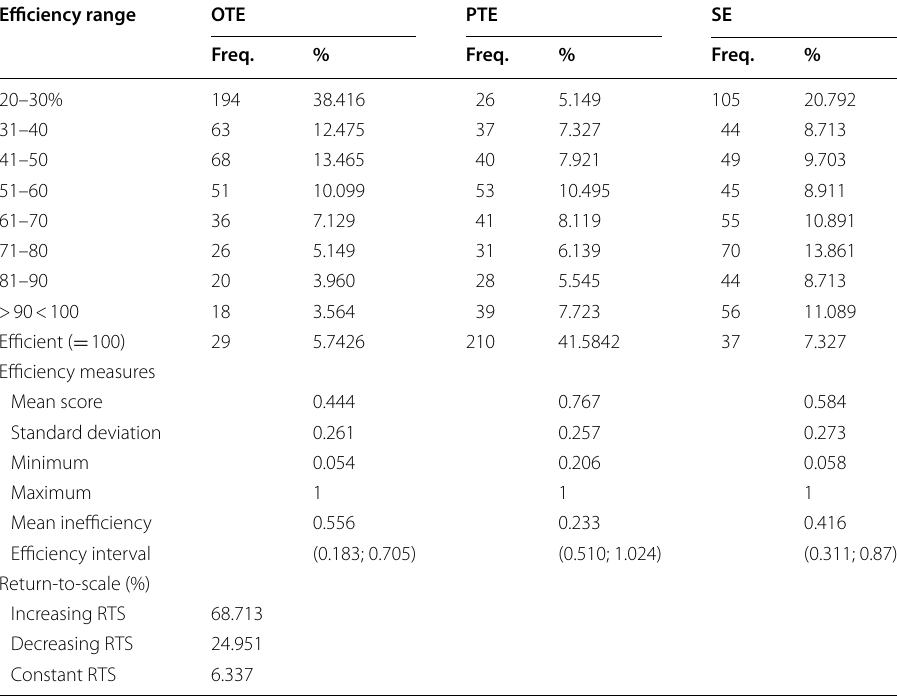
OTE, PTE and SE denote overall technical efficiency, pure technical efficiency and scale efficiency, respectively